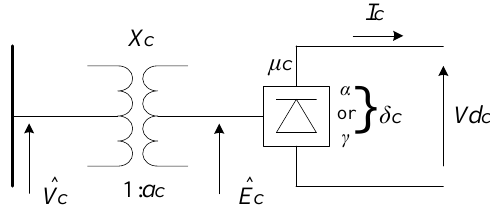
Figure 1. Converter model